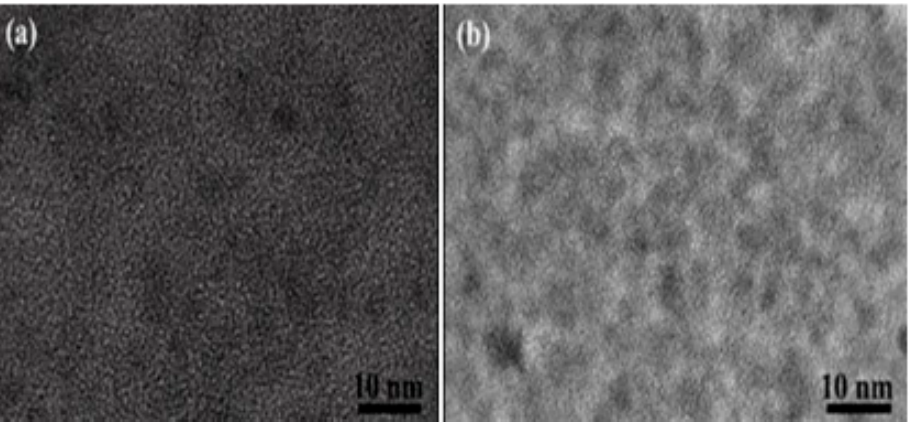
Figure 6. ( a ) HRTEM image of ZCGQDs; ( b ) HRTEM image of ZCGQDs after Cu 2+ was added.